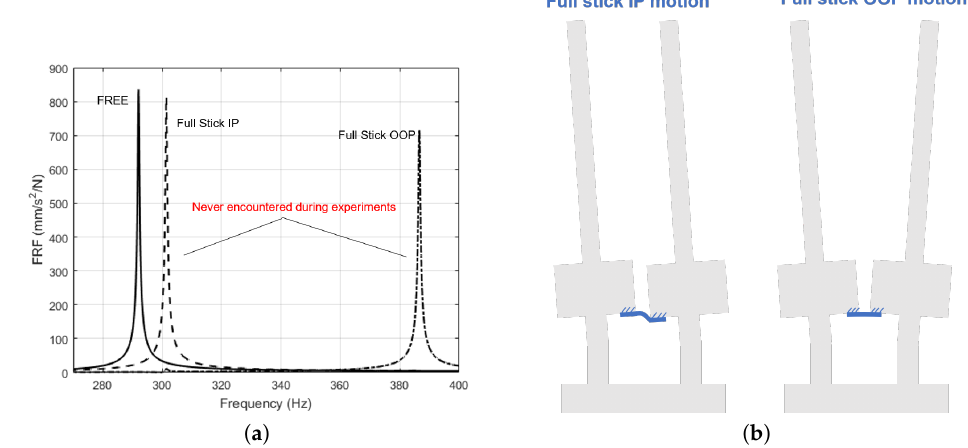
Figure 9. ( a ) Free (i.e., no strip) numerical FRF compared to IP and OOP numerical full stick FRFs ( b ) Graphical representation of IP and OOP numerical full stick bending modes of vibration of blades-strip